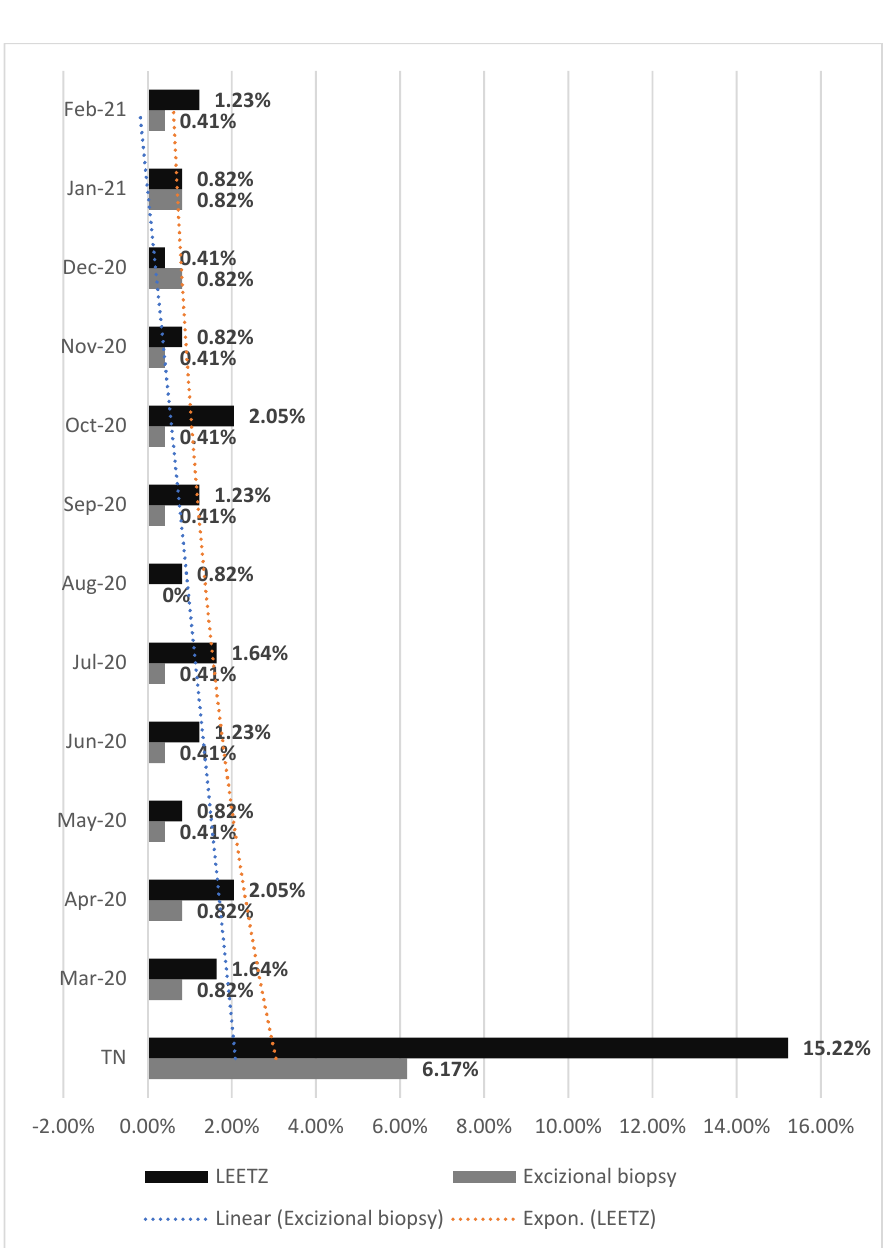
Figure 7. Surgical procedures were performed in both clinics of the Emergency County Hospital in the year of the SARS-CoV-2 pandemic. SP: first year of SARS-CoV-2 pandemic period; LEETZ: Large loop excision of the transformation zone; TN: Total number of surgical procedures performed. After performing the excisional biopsy or LEETZ for the 243 patients, the fragments of tissue excised were sent to the Pathological Anatomy Service for histopathological examination. The fragments from the excised tissues were examined using classical staining techniques, such as hematoxylin–eosin and immunohistochemical staining with Ki-67 antibodies to identify the lesion degree (CIN1/2/3). In CIN 1, the basal layer was stained; in CIN2, the basal layer and intermediate layers were stained; in CIN3, all layers—basal layer, intermediate layers, and superficial layers—of the epithelium were stained, and in MCC, the neoplastic cells crossed the basement membrane (Figures 8 and 9).